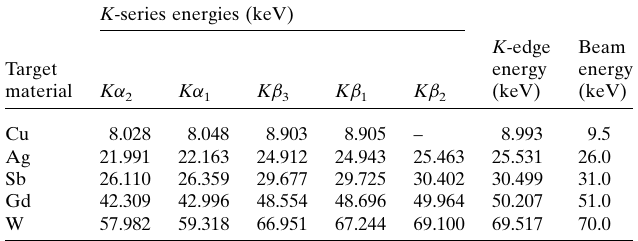
Table 2 Characteristic emission lines and K -edge energies from Arndt et al. (2006) with the selected fluorescent targets and incident-beam